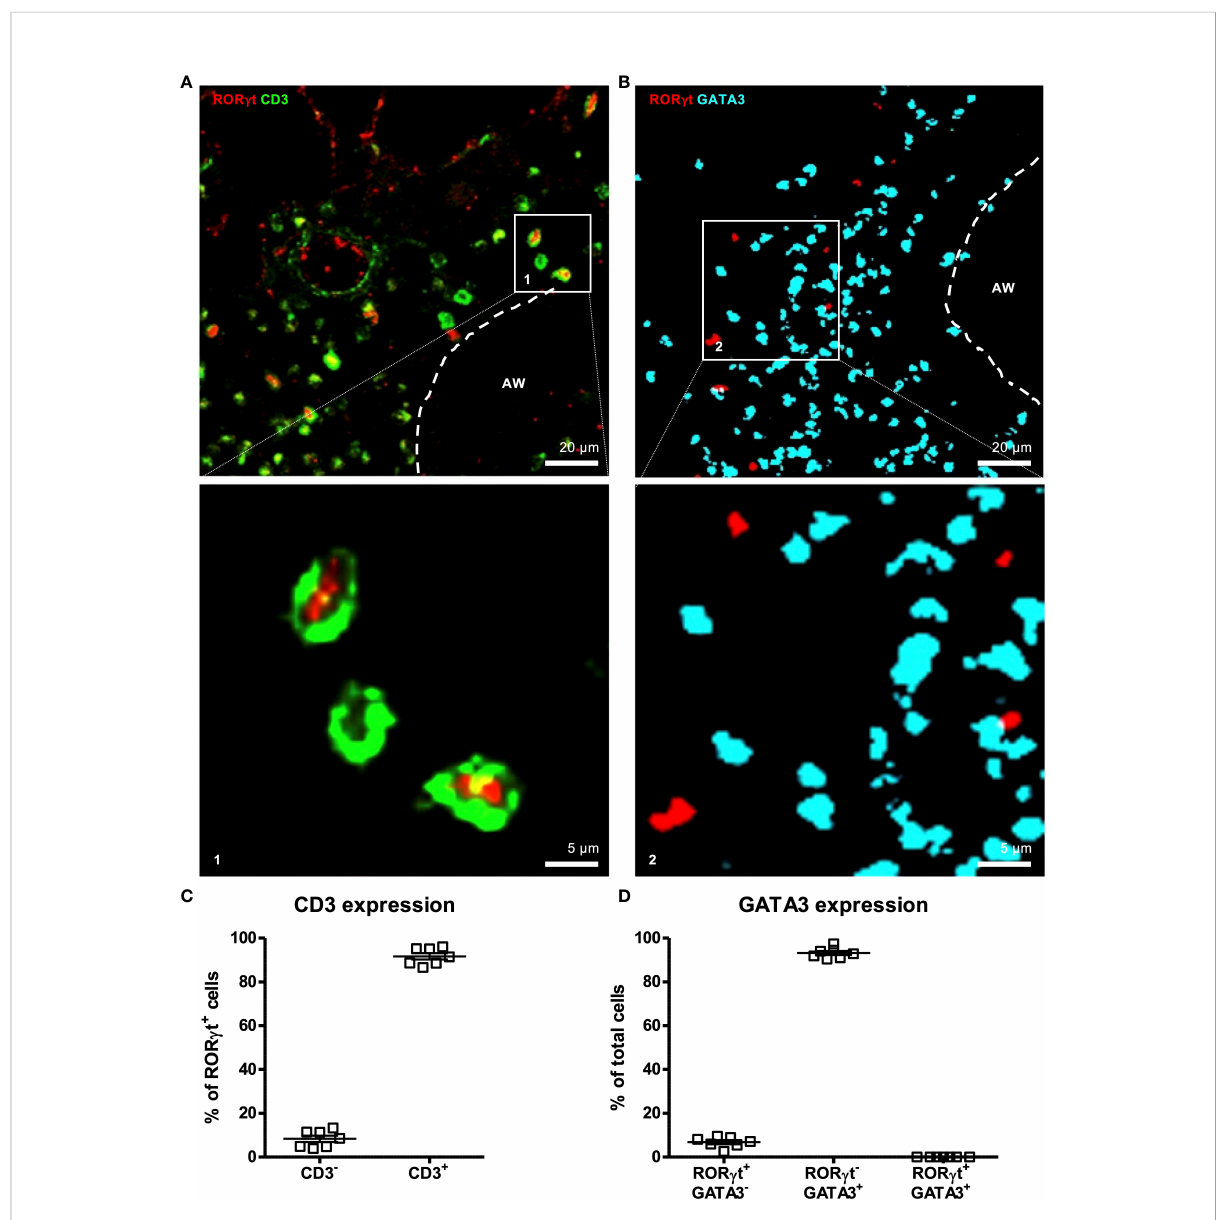
FIGURE 3 ROR g t is suitable as a marker for pulmonary IL-17A + cells in situ . At 6-8 weeks C57BL/6 mice were immunized i.p. with 10 µg/100 µL of HDM. Seven days later mice received an additional i.p. injection of HDM. After 14 and 21 days mice were treated with 100 µg/40 µL HDM i.t. 72 h after the last treatment 300 µm lung sections of agarose fi lled lungs were prepared and stained with anti-ROR g t (red) and anti-CD3 (green) (A) or anti-ROR g t (red) and anti-GATA3 (turquoise) (B) . (C) ROR g t + cells were analyzed regarding CD3 expression. (D) Total cells were analyzed regarding ROR g t and GATA3 expression. Stained slices were evaluated with confocal microscopy. Abbreviations: AW, airway. Data are representative of two independent experiments. Scatter plot with mean ± SEM; n = 7 mice. Each dot represents the Z-stack of one